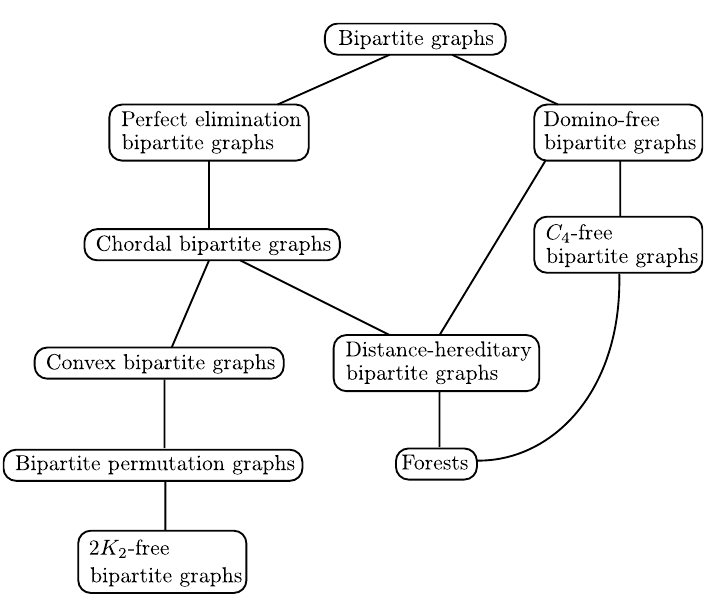
Fig. 3: A hierarchy of bipartite graph